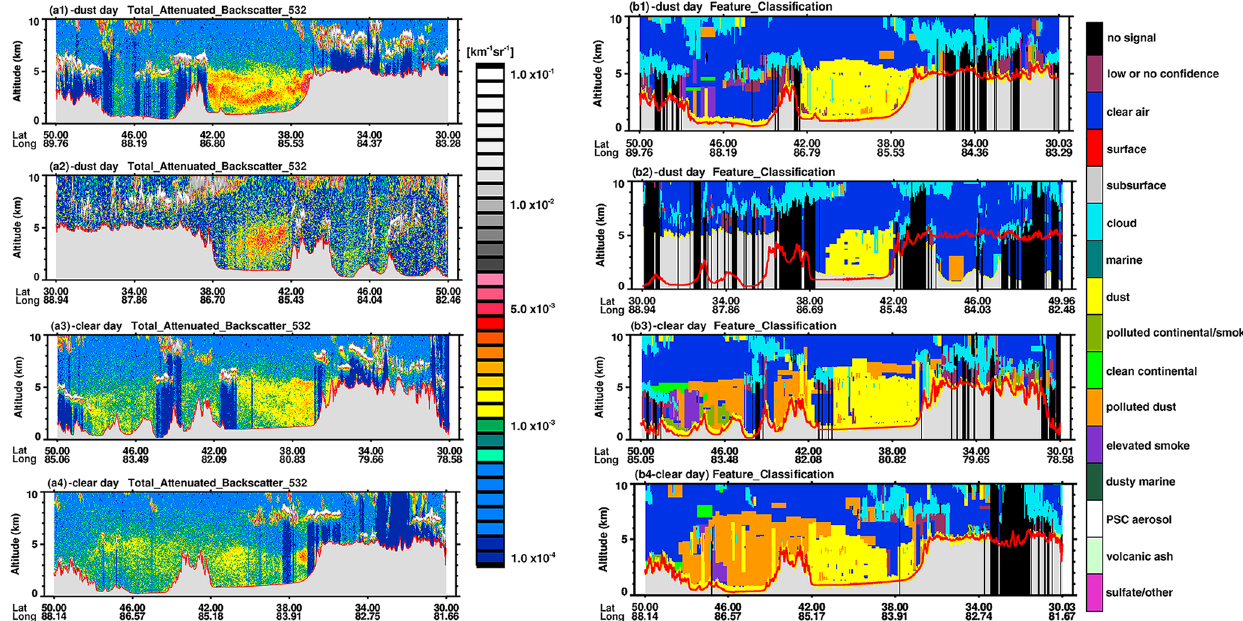
Figure 4. The altitude–orbit cross section of the 532nm total attenuated backscattering intensity (left panels) and classified particles (right panels) on ( a 1 and b 1) 4 July, ( a 2 and b 2) 5 July, ( a 3 and b 3) 25 July, and ( a 4 and b 4) 27 July 2016, along the trajectory of the CALIPSO satellite over the Tibetan Plateau, as presented in Fig. 1. Gray shadings indicate the